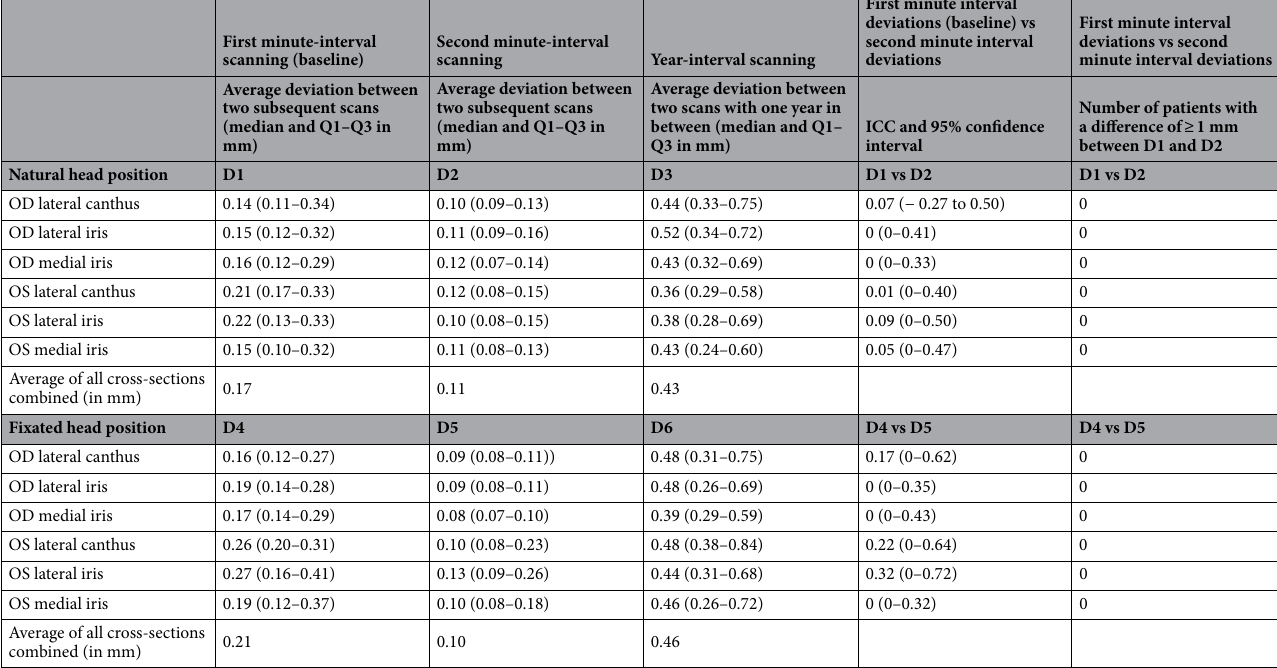
Table 1. Descriptive statistics and intra-tool reliability (ICC and 95% confidence intervals). 1 min-interval versus 1 year-interval: median of average deviations between the two curves from the natural head position (NHP) and the two curves from the fixated head position (in mm). The shown intraclass correlation coefficients (ICC) and 95% confidence intervals are all < 0.9. OD oculus dexter (right eye), OS oculus sinister (left